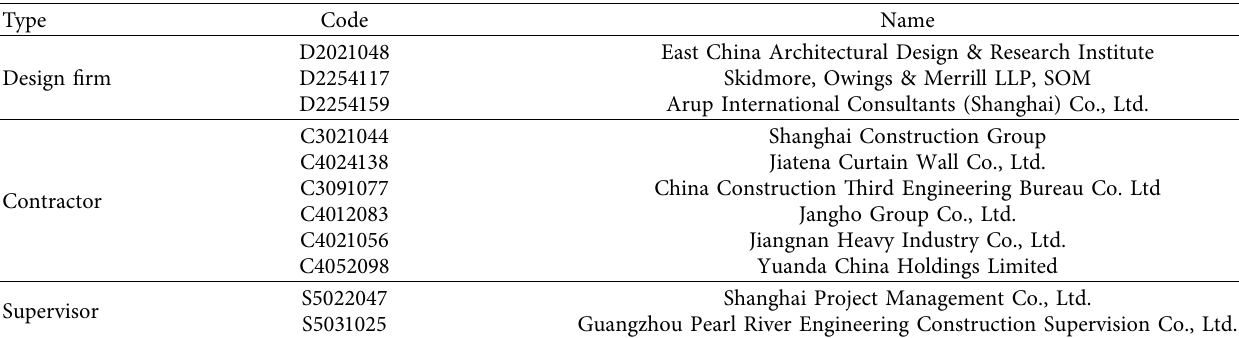
Table 5: The company names of the organizations in Table